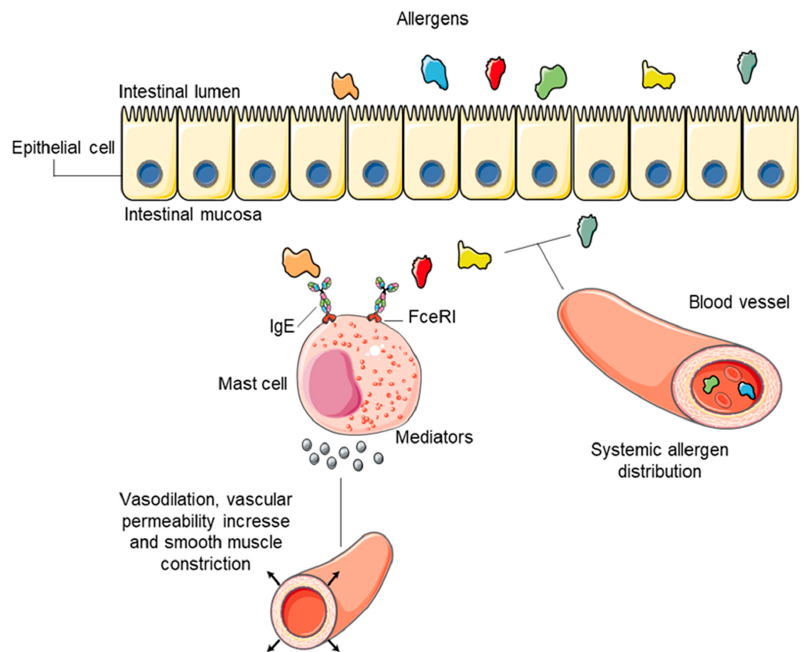
Figure 1. General mechanisms of IgE mediated response to food allergens. Interaction between food allergens and IgE and its high-affinity FC receptor (FCER1) on basophils in circulation or mast cells present in mucosal tissues leading to their activation and consequent physiological response. Adapted from Renz, Allen, Sicherer, Sampson, Lack, Beyer and Oettgen [22]. Adapted with permission from Ref. [22]. Copytright 2018. Springer